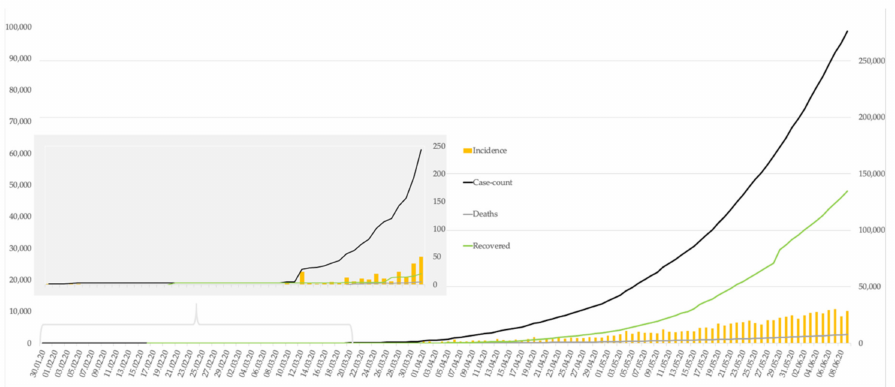
Figure 1. Epidemiological progress of the COVID-19 outbreak in India. Incidence is scaled according to the left axis. Data were derived from Johns Hopkins Center for Systems Science and Engineering (JHU